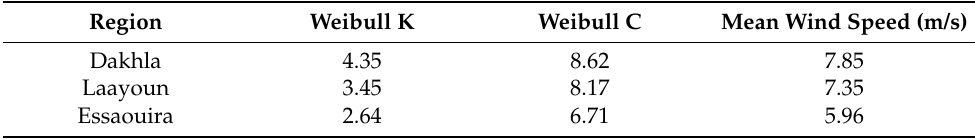
Table 3. Weibull parameters for the chosen regions [48].